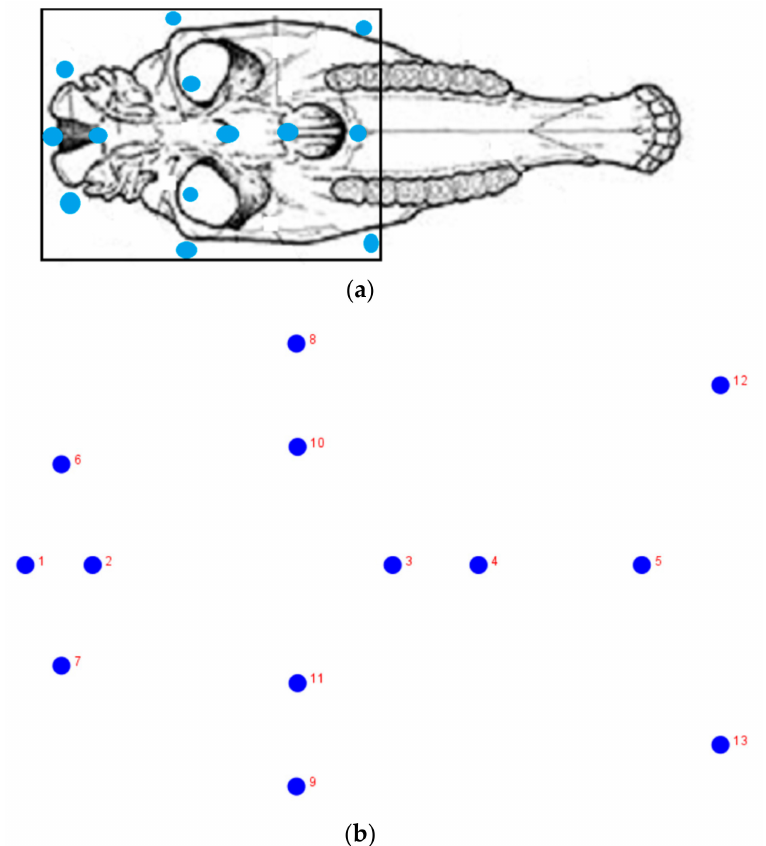
Figure 1. Scheme illustrating the set of 13 landmarks ( b ) used on the ventral aspect of the skull ( a ): 1—Most caudal point of the foramen magnum ; 2—Most rostral point of the foramen magnum